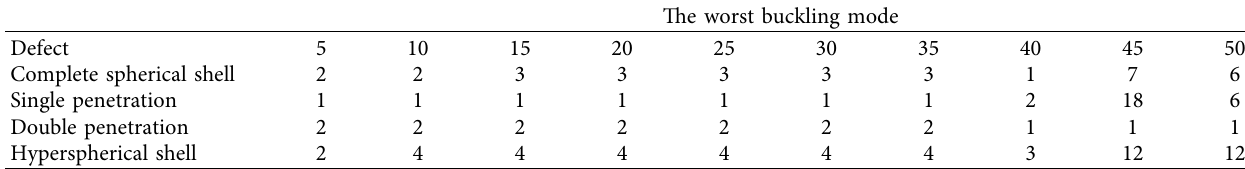
Table 2: The worst mode of the spherical shell under different defect amplitudes.